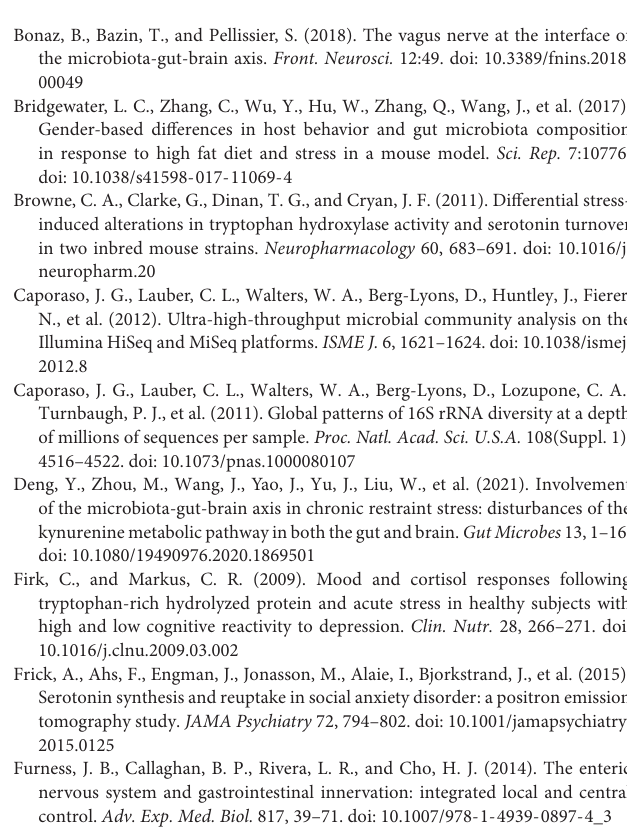
Supplementary Figure 1 | Relative abundance of 5 most abundant phylum for cecal (A) and fecal (B) murine bacterial communities, visualized for every combination of the fixed effects diet, sex and stress. Stress encompassed a chronic alternating forced swim and restraint stress paradigm as described in section “Materials and